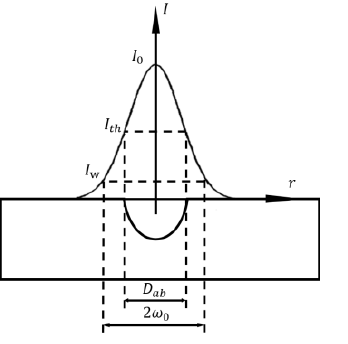
Figure 13. Energy density and fabricating depth (Adapted with permission from Ref. [65]. 2004, Mannion, P.T.).